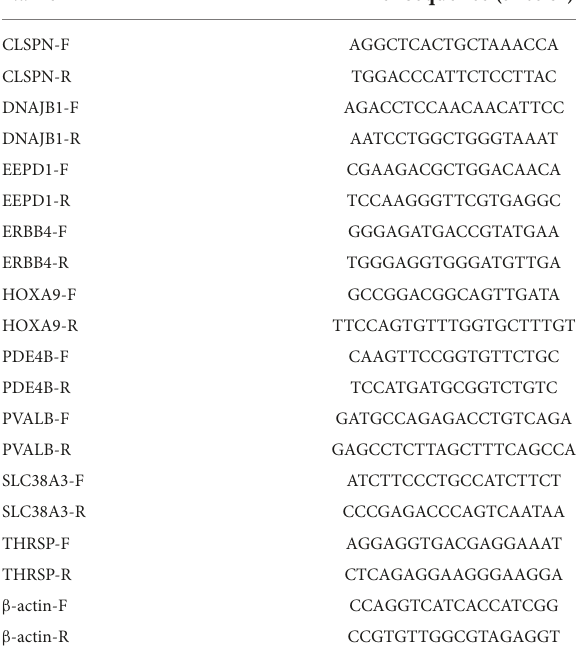
TABLE 1 Primers used to verify the quality of